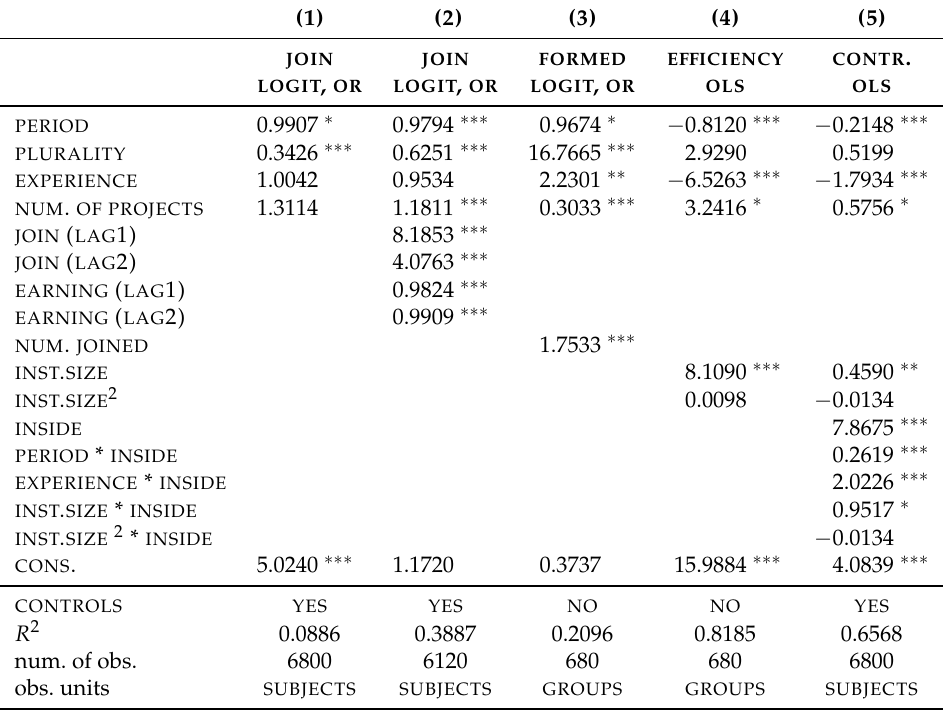
Table 5. Regression analysis of strategic behaviour (institution formation and